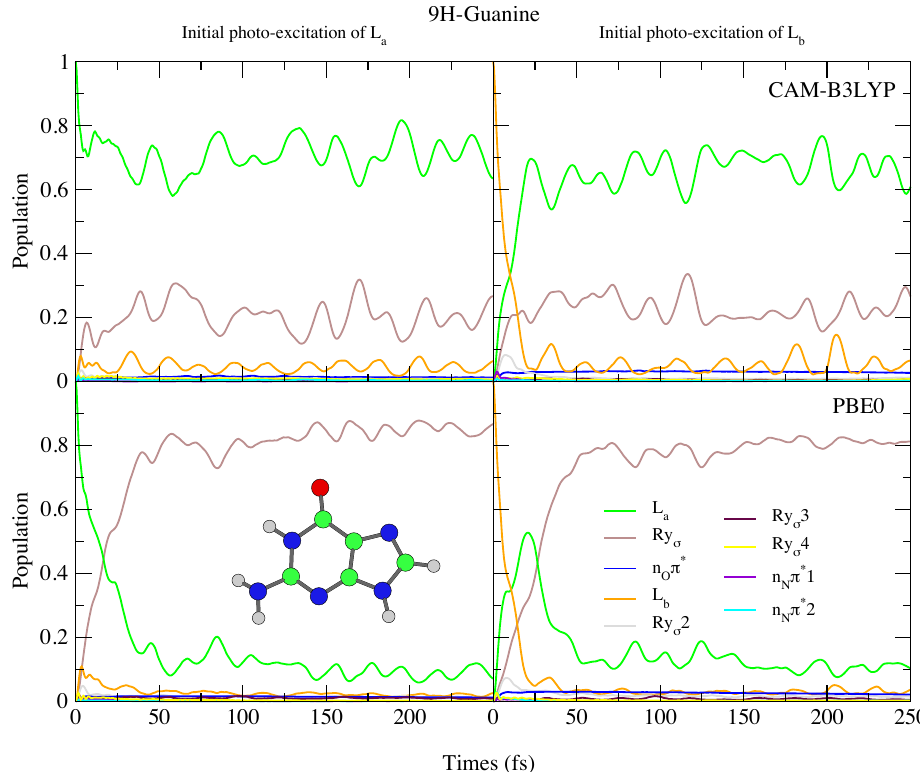
Figure 10. Nonadiabatic dynamics of electronic populations of 9H-Guanine in the gas phase, as predicted by an LVC Hamiltonian parameterised with calculations using CAM-B3LYP ( top ) and PBE0 ( bottom ) functionals with 6-311+G(d,p) basis